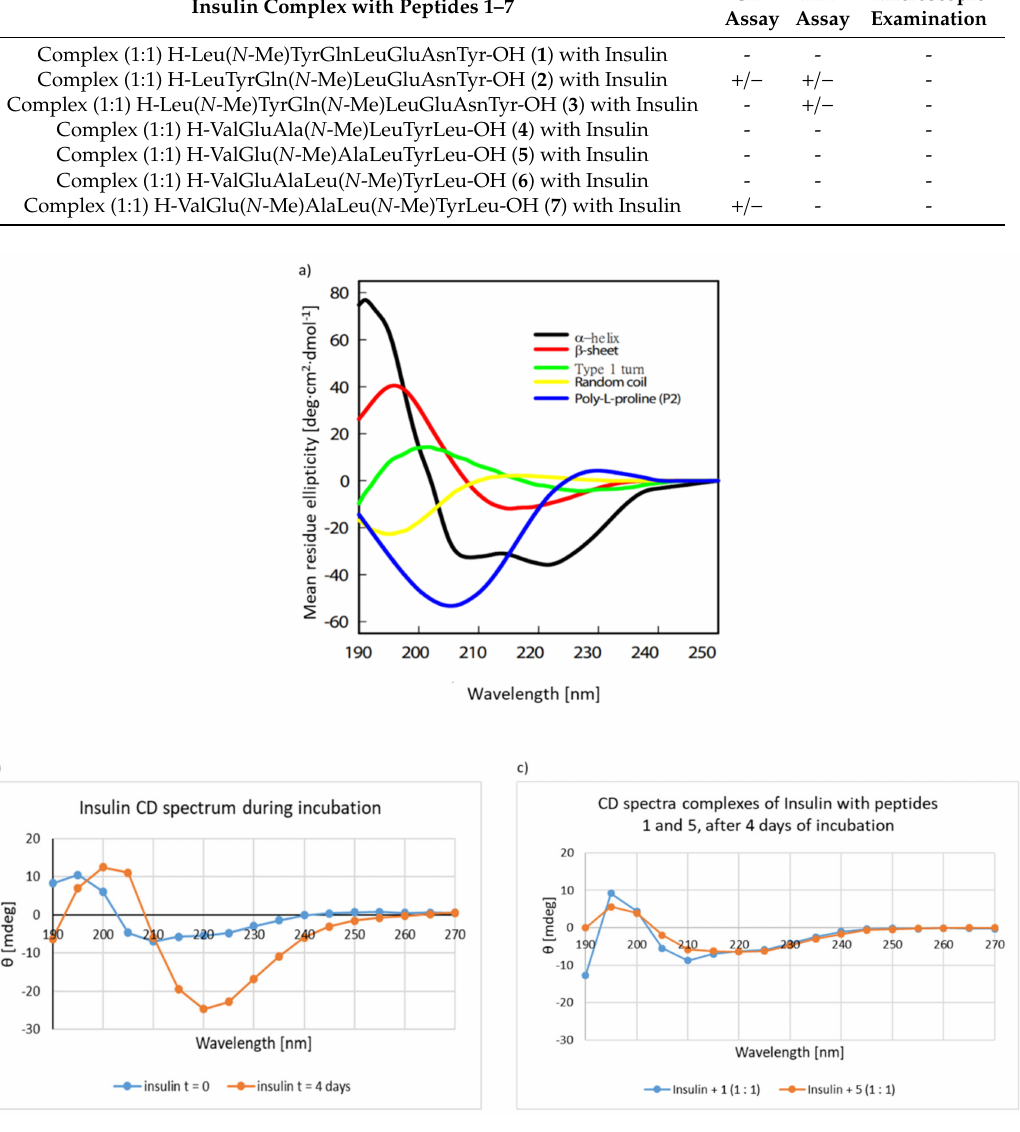
Figure 6. CD spectra. ( a ) model protein with stable secondary structure, ( b ) insulin, ( c ) complexes of insulin with peptides 1 and 5 . The peptides and complexes were incubated in phosphate bu ff er solution, pH 7.2, concentration 0.1 mg / mL at 37 ◦ C, t = 0 (CD spectrum of insulin after dissolving the sample); t = 4 days (CD spectrum of peptides after 4 days of